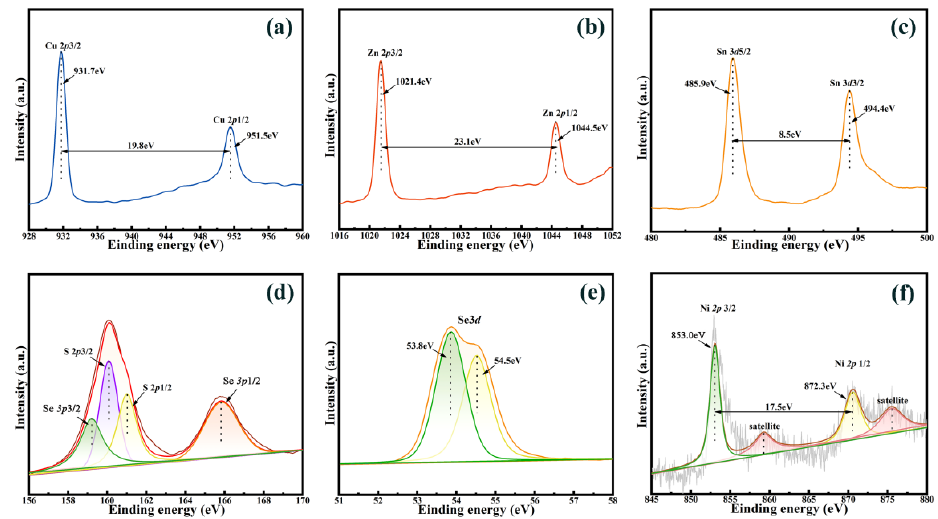
Figure 6. XPS spectra of CNZTSSe films selenized at 540 °C: ( a ) Cu 2p, ( b ) Zn 2p, ( c ) Sn 3d, ( d ) S 2p, ( e ) Se 3d, and ( f ) Ni 2p.